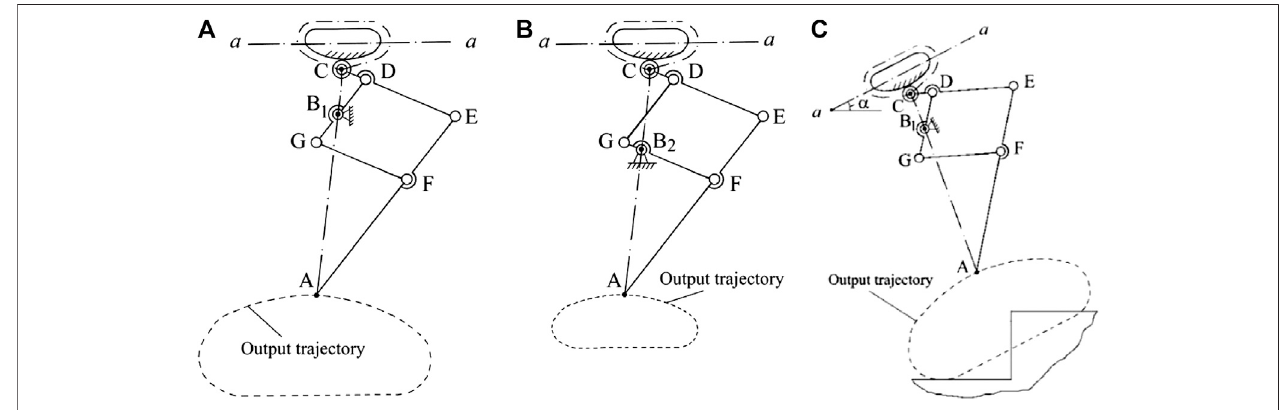
FIGURE 3 | Leg mechanism with different output trajectories (A . fi xed point on B1, B . fi xed point on B2, C . with a cam inclination angle α